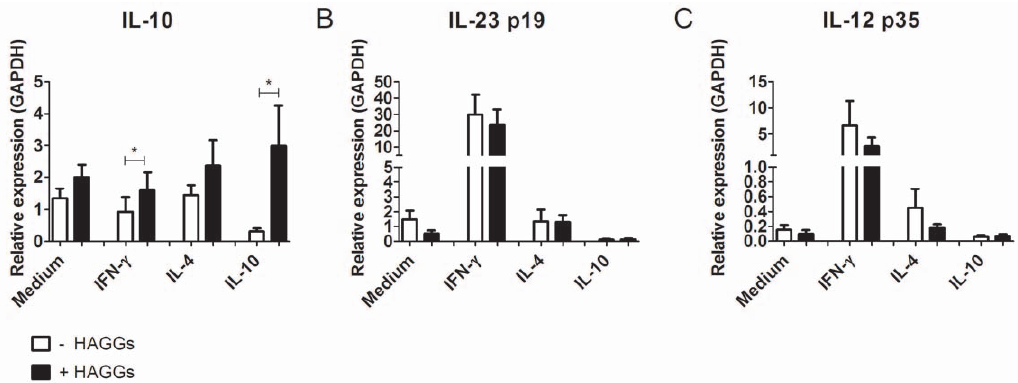
Figure 6. mRNA expression of IL-10, IL-23p19, and IL-12p35 after macrophage stimulation with HAGGs and LPS. Healthy peripheral blood monocytes were cultured for 4 days in medium or in medium supplemented with IFN- c , IL-4, or IL-10. Polarized macrophages were stimulated for 7 hours with LPS, in the presence or absence of HAGGs. mRNA expression levels were measured by quantitative RT-PCR and were normalized to those of the human housekeeping gene GAPDH. Bars represent the mean 6 SEM of 6 independent experiments. *p , 0.05.